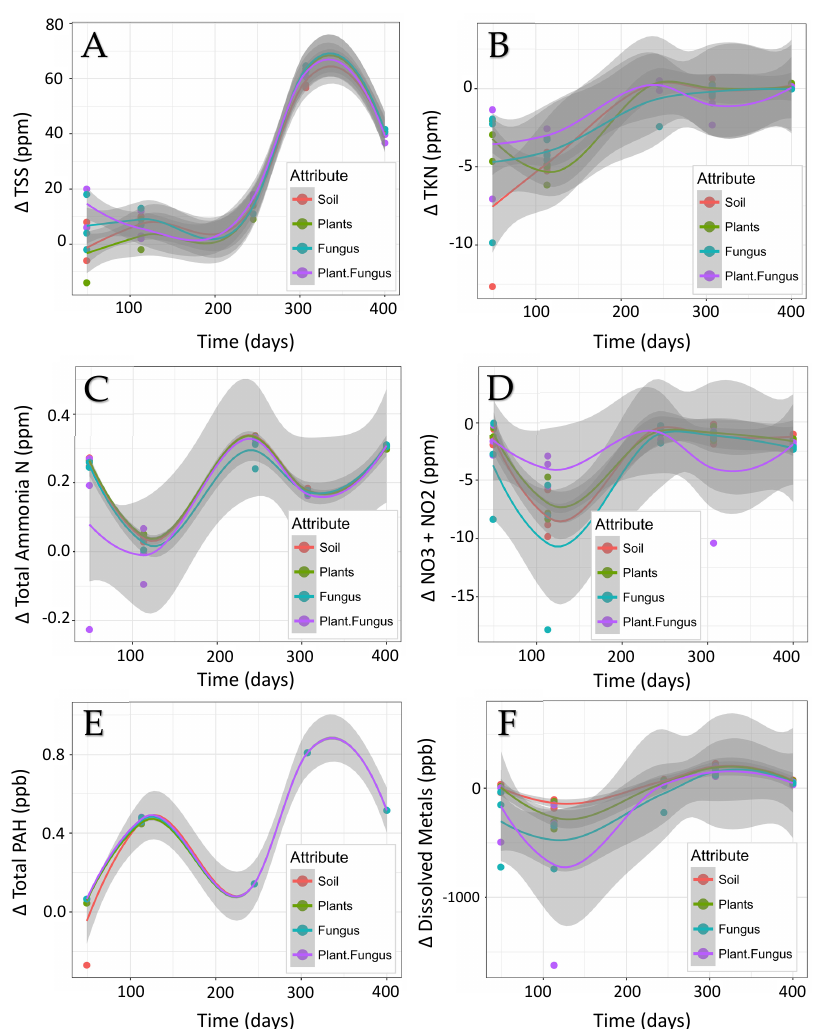
Figure 6. Non-parametric Locally Weighted Scatterplot Smoothing (LOESS) for total suspended sediment ( A ), total Kjeldahl nitrogen ( B ), ammonia + ammonium ( C ), nitrate + nitrite ( D ), total polycyclic aromatic hydrocarbons ( E ) and total dissolved metals ( F ) as functions of time with each biological amendment factor presented independently. All data are presented as concentration removed (positive values) or as concentration exported (negative